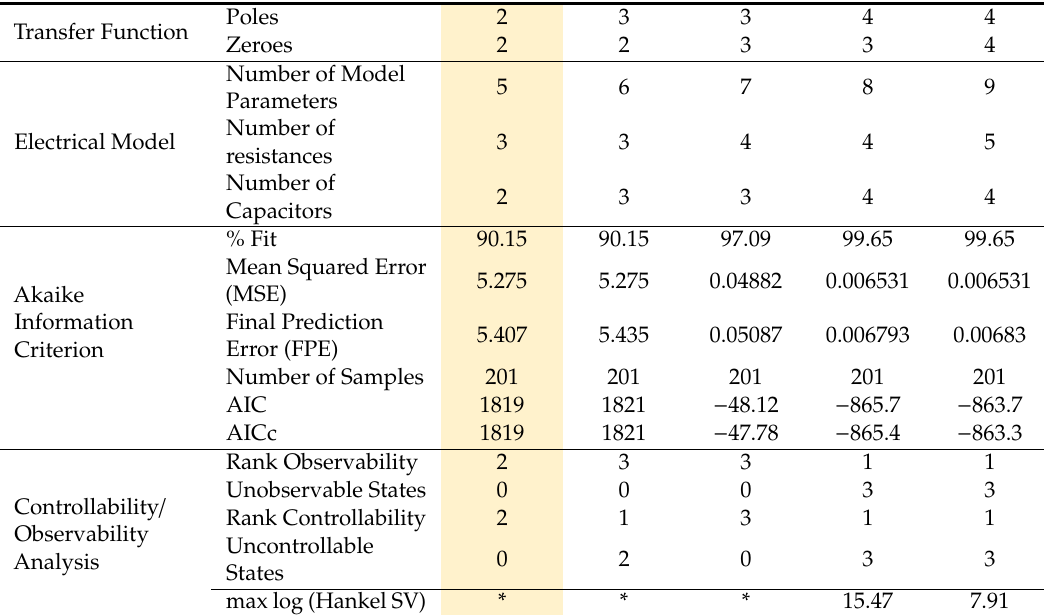
Table 6. Summary of model estimation for